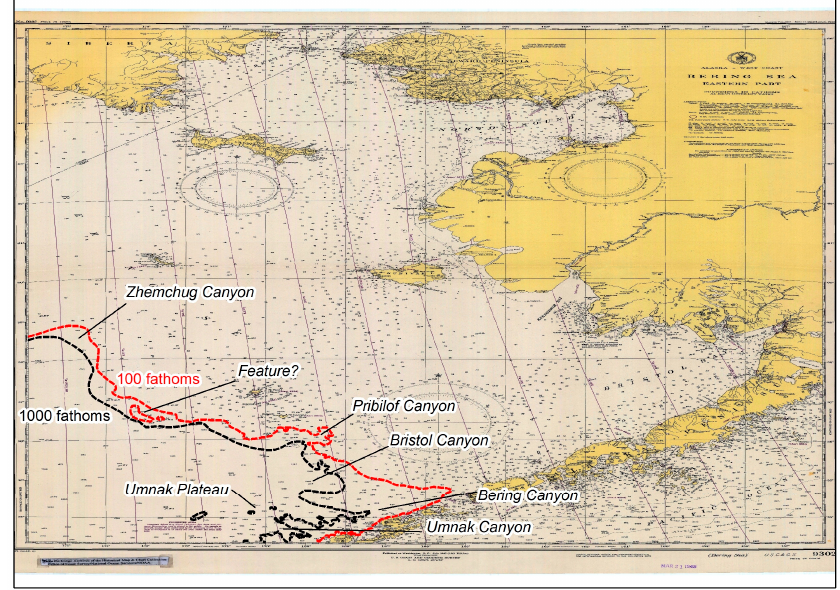
Figure 2. NOS navigational Chart 9302 from 1948. Eastern Bering Sea slope canyons are poorly defined by dashed lines for the 100 (traced in red) and 1000 (traced in black) fathom depth contours. This chart was replaced by Chart 16006 in 1975.